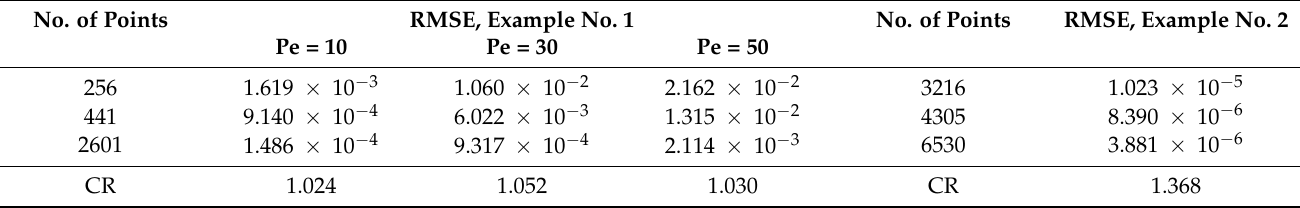
Table 12. Example Nos. 1 and 2—values of RMSE and the convergence rates (CR). No. of Points